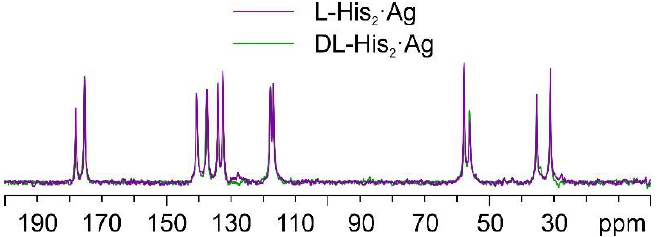
Figure 15. Overlay of the 13 C CPMAS spectra of L-His 2 ·Ag (in purple) and DL-His 2 ·Ag (in green).